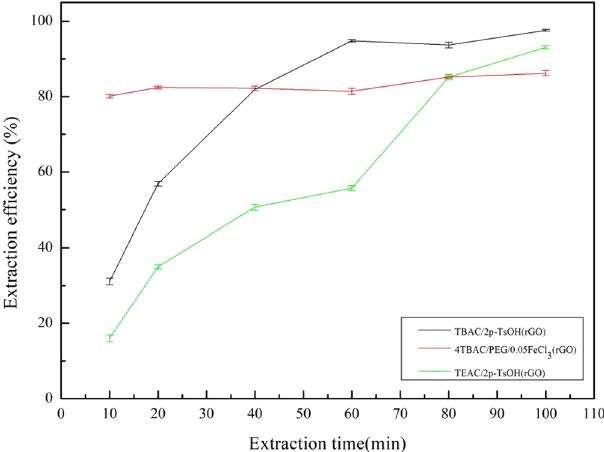
Figure 8. The effect of extraction time on the extraction efficiency (experimental conditions: 1.2 g composite material, 0.5 g simulated oil (1600 mg/L sulphur content), 25 °C, 800 rpm).